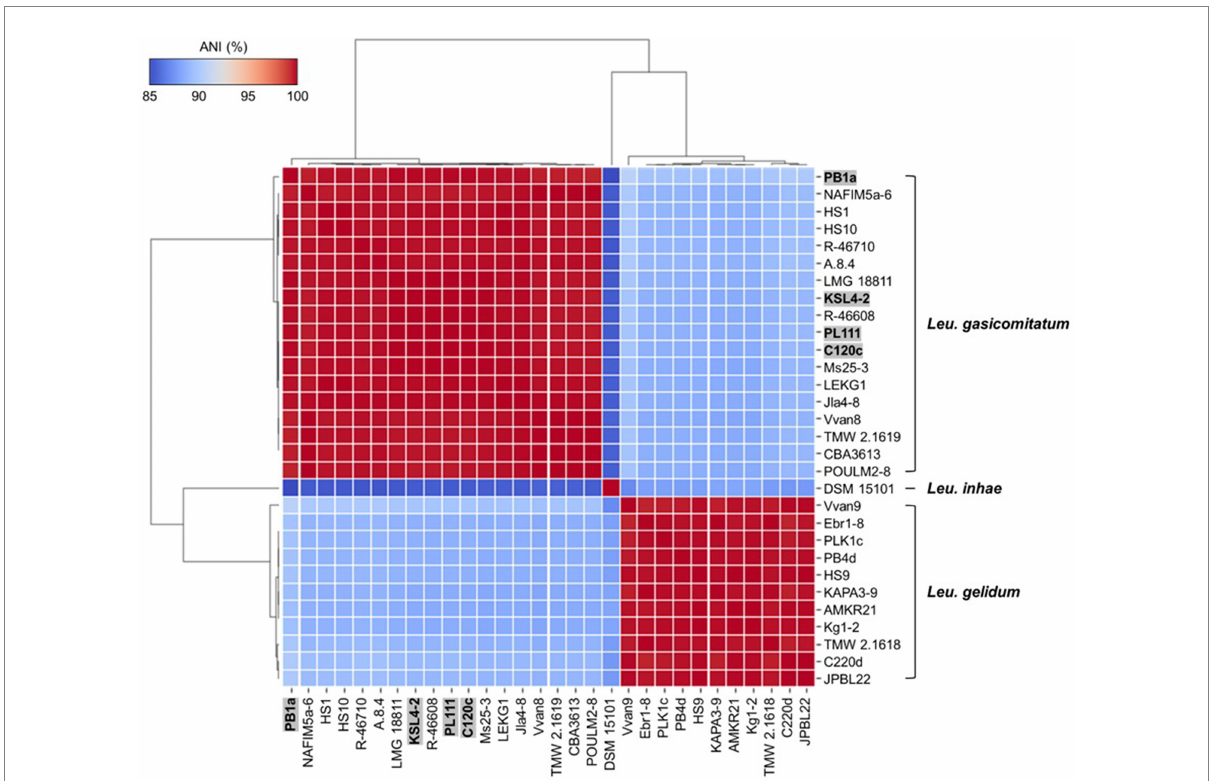
FIGURE 2 Heatmap of average nucleotide identity (ANI) values among Leu . gelidum , Leu . gasicomitatum , and Leu . inhae strains. Misclassified genomes are highlighted in grey box with bold letters. Strain names and accession numbers are listed in Supplementary Table S1